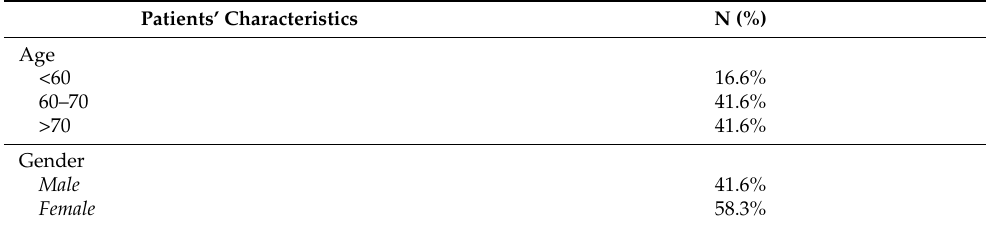
Table 1. Characteristics of